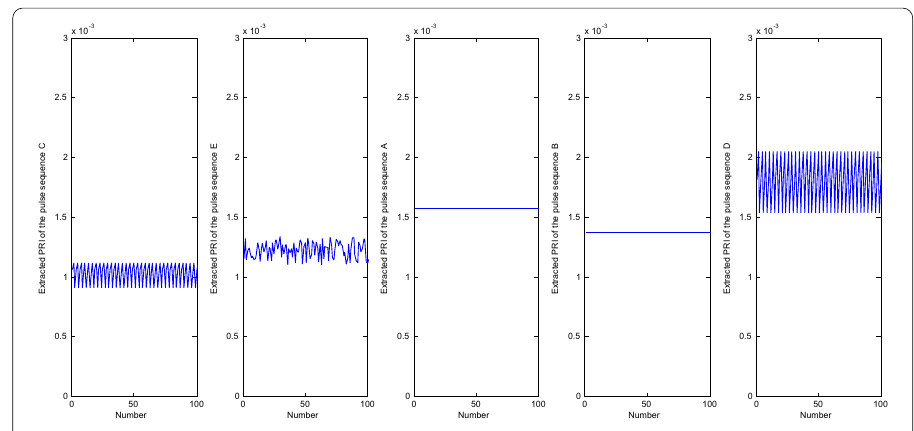
Fig. 6 Diagram of PRI changes of separated pulses sequence of emitters in the Table 1